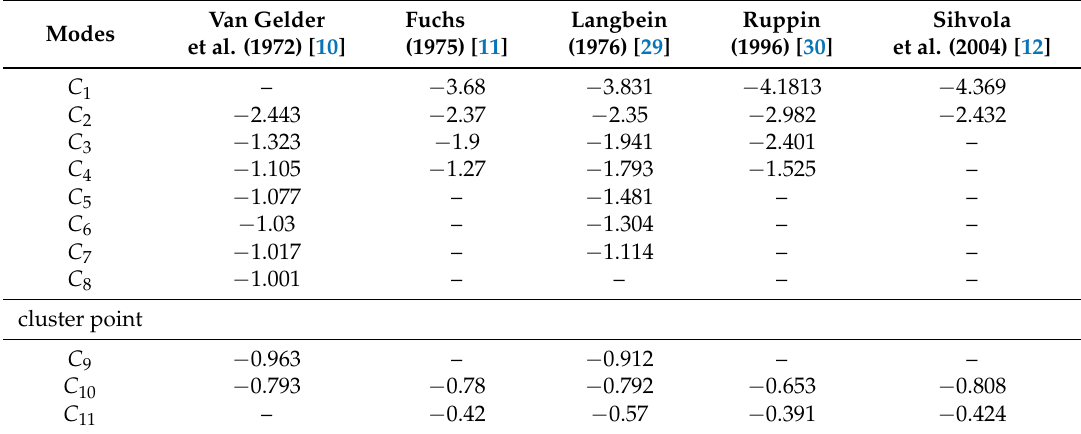
Table 2. Comparative table of the position of the plasmonic resonances of a cube of permittivity ε